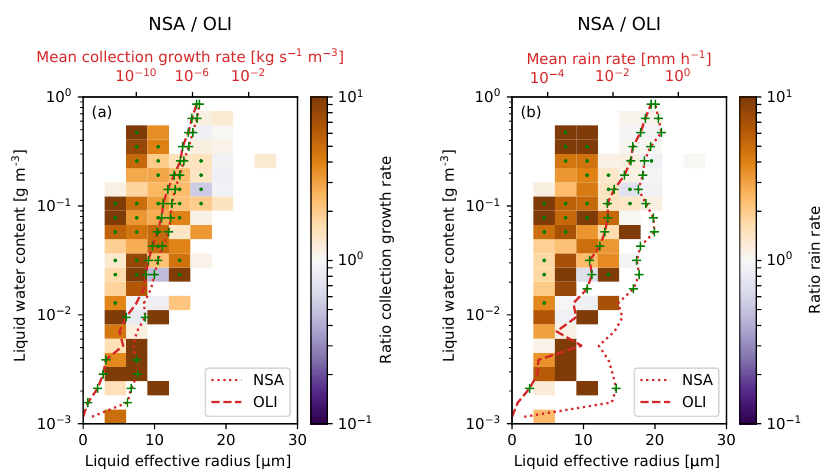
Figure 6. As Fig. 4, but with the coloured shading representing the site-to-site ratio (NSA / OLI) of the collection kernel growth rate C (a) and the rain rate R (b) . The rates averaged over r eff are shown in red for NSA (dotted) and OLI (dashed). The green dots and crosses highlight data points with a significant difference (5% confidence